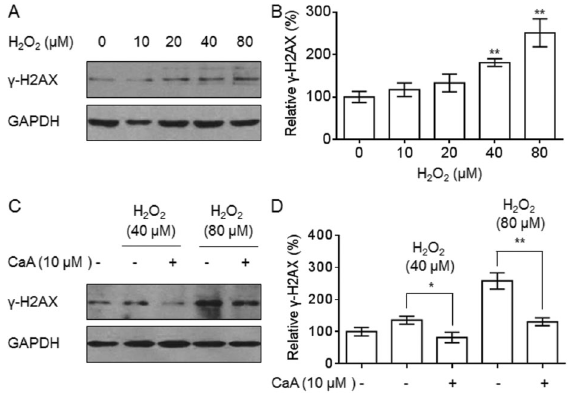
Figure 2. Caffeic acid (CaA) decreased H 2 O 2 -induced double- strandbreads(DSBs)inL-02cells. A , B , L-02cells wereexposedto 0, 10, 20, 40, or 80 m M H 2 O 2 for 6 h. A , Western blot analysis and B , relative c -H2AX protein levels. **P , 0.01 compared with control cells. C , D , L-02 cells were pretreated with 0 or 10 m M CaA for 24 h and then exposed to 40 ( lanes 2 and 3 ) or 80 ( lanes 4 and 5 ) m M H 2 O 2 for 6 h. C , Western blot analysis and D , relative c -H2AX protein levels. *P , 0.05 and **P , 0.01 compared with L-02 cells treated with H 2 O 2 alone (Student’s t -test). Bands were normalized to glyceraldehyde 3-phosphate dehydrogenase (GAPDH).